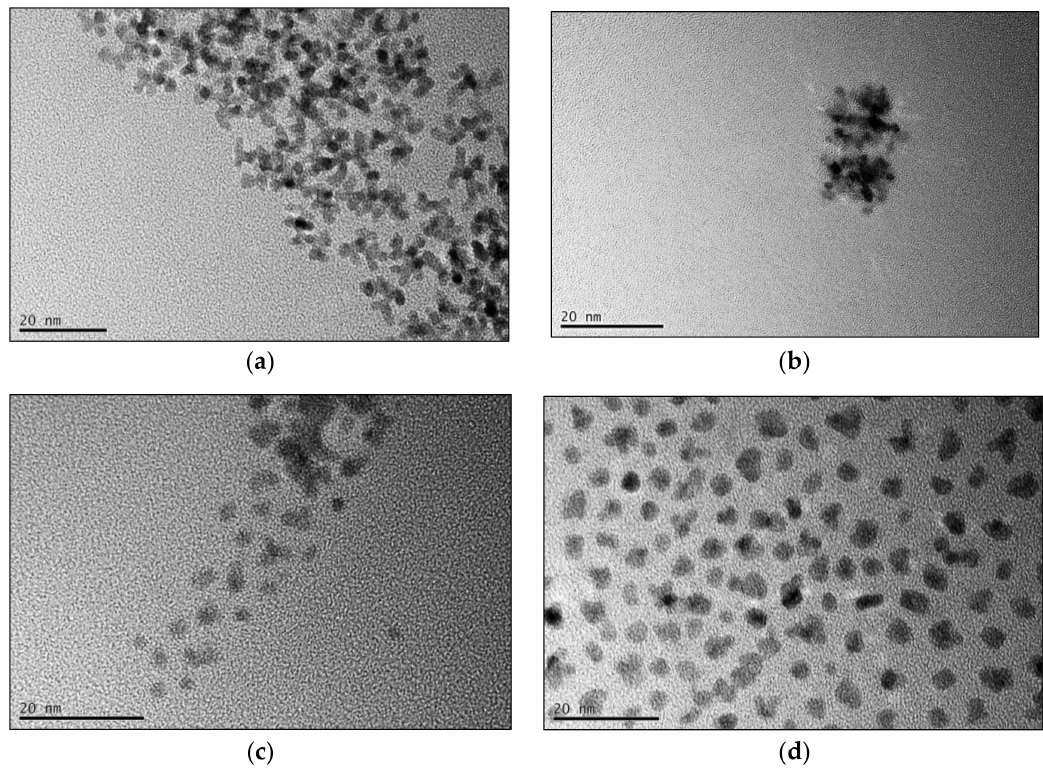
Figure A3. Transmission electron microscopy images of the 5 and 15 min samples of the benzylamine ( a , b ) and triethylene glycol ( c , d ) routes were used to analyze the particle growth during synthesis. Thereby, FePt particles derived by the BnNH 2 route additionally reveal an increased formation of agglomerates. For TEG, an increase in the particle size, as well as a more edgy shape, could be observed.